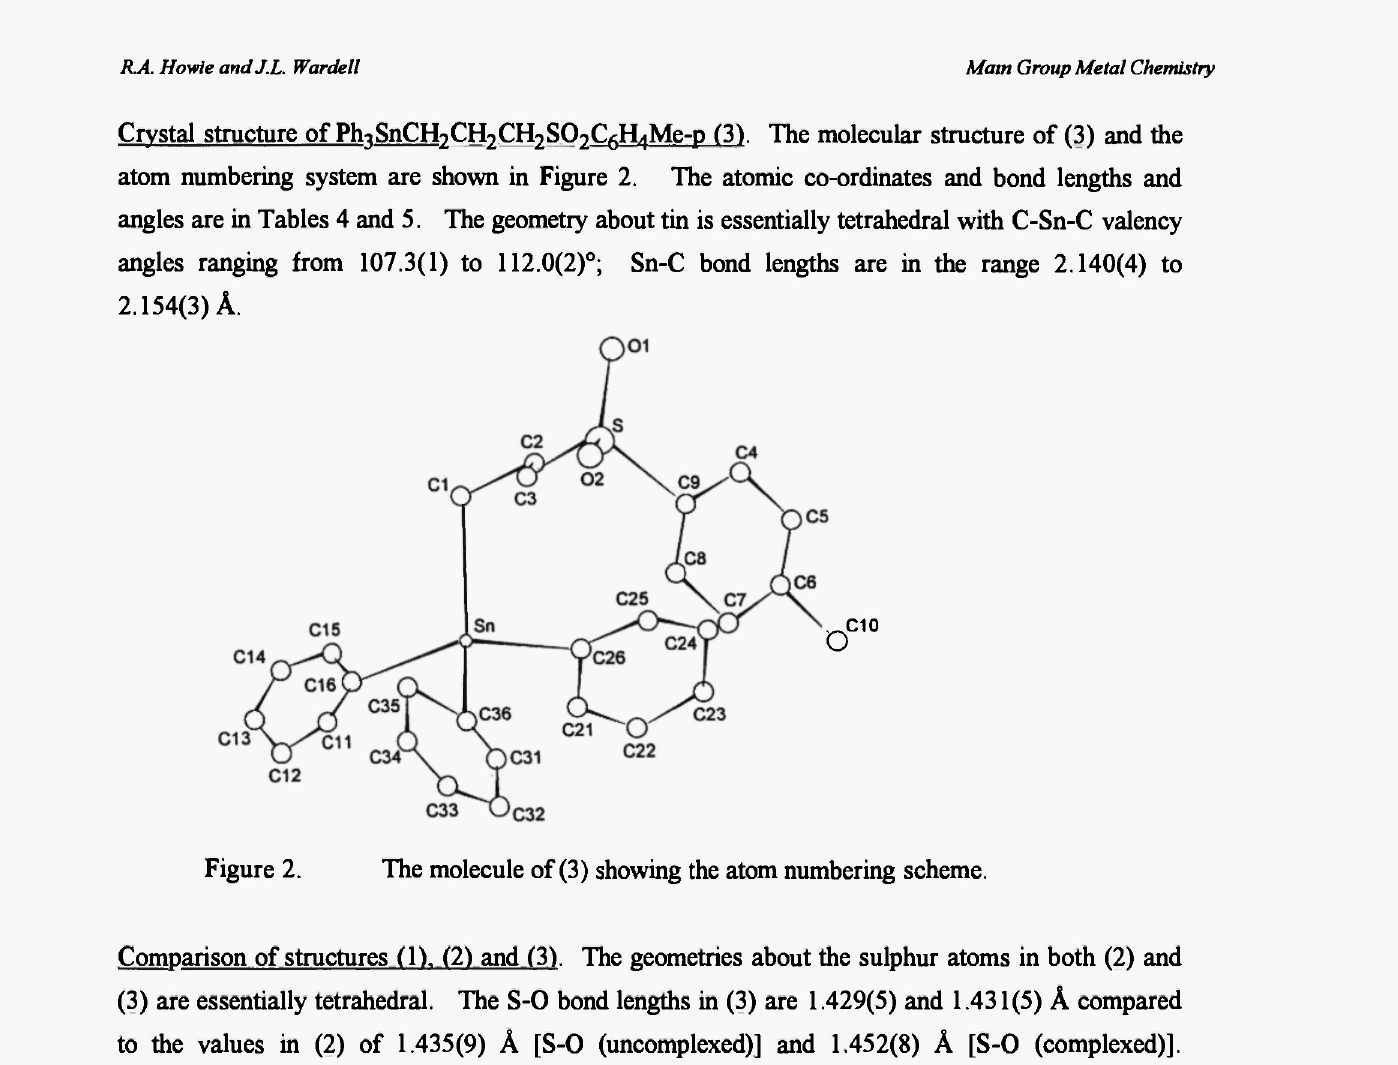
Figure 2. The molecule of (3) showing the atom numbering